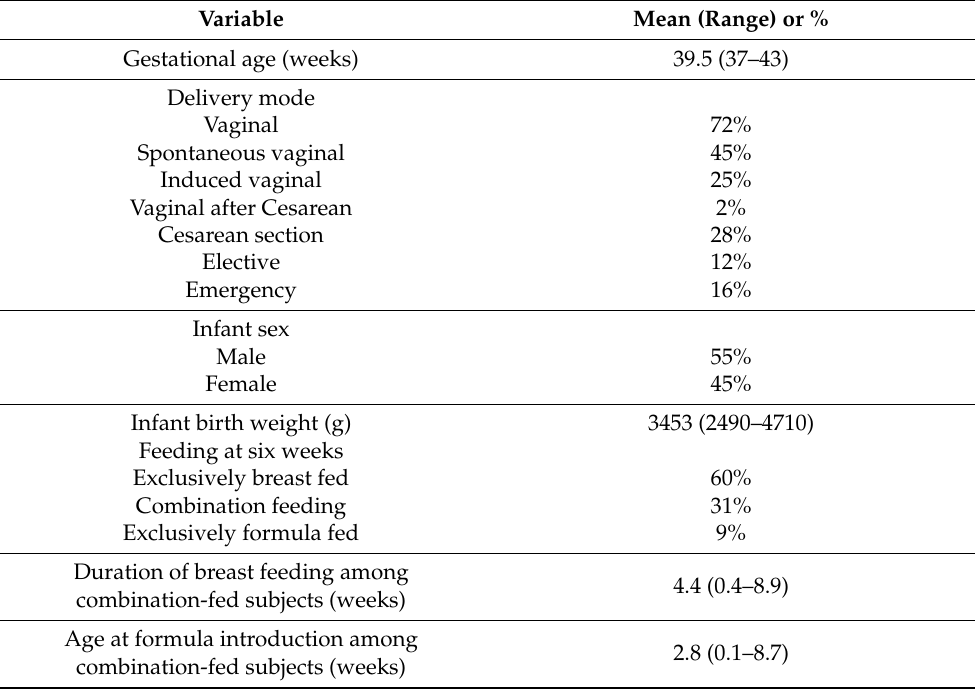
Figure 1. Flow diagram: 215 infants enrolled in the New Hampshire Birth Cohort Study provided a 6-week stool sample. Infants from this group were removed from the current study either because their stool sample was not available for metabolomics analysis ( n = 87) or because they were born prematurely ( n = 7), leaving 121 subjects for inclusion in the present study. Table 1. Subject characteristics ( n =